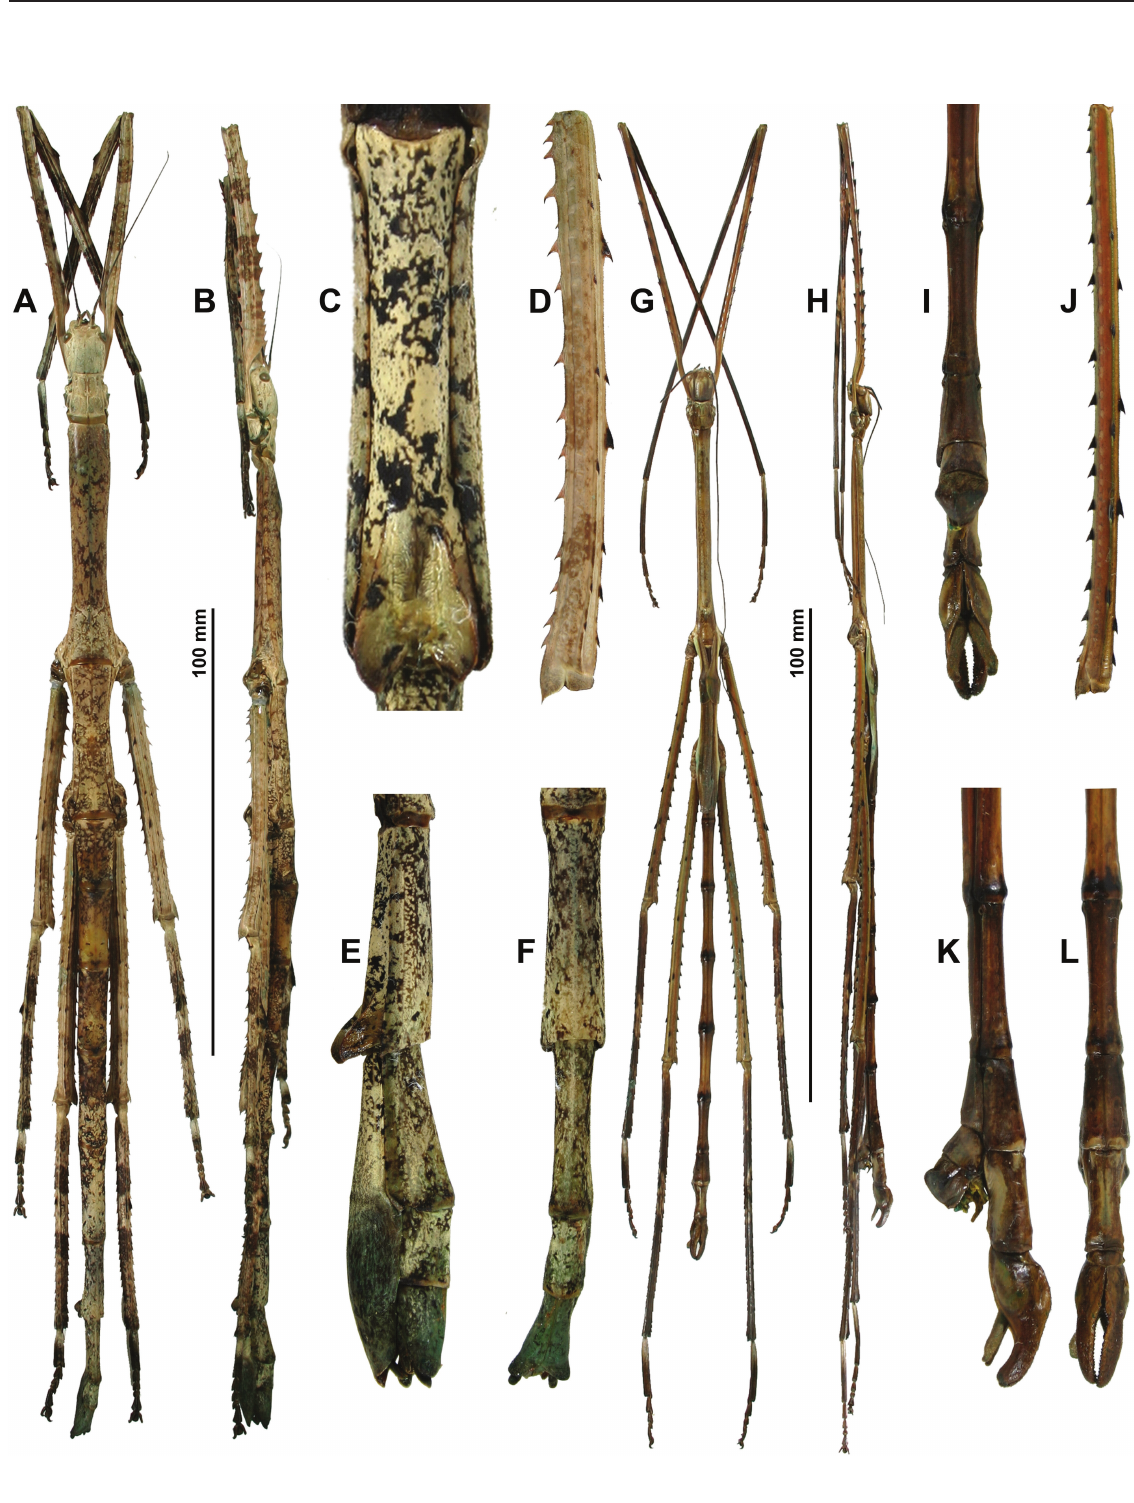
Fig. 9. Phobaeticus trui sp. nov. — A–F . ♀. A . Habitus, dorsal view. B . Habitus, lateral view. C . Sternum VII and praeopercular organ. D . Mesofemur, lateral view. E . Apex of abdomen, lateral view. F . Apex of abdomen, dorsal view. — G–L . ♂. G . Habitus, dorsal view. H . Habitus, lateral view. I . Apex of abdomen, ventral view. J . Mesofemur, lateral view. K . Apex of abdomen, lateral view. L . Apex of abdomen, dorsal view. C–F, I–L = not to